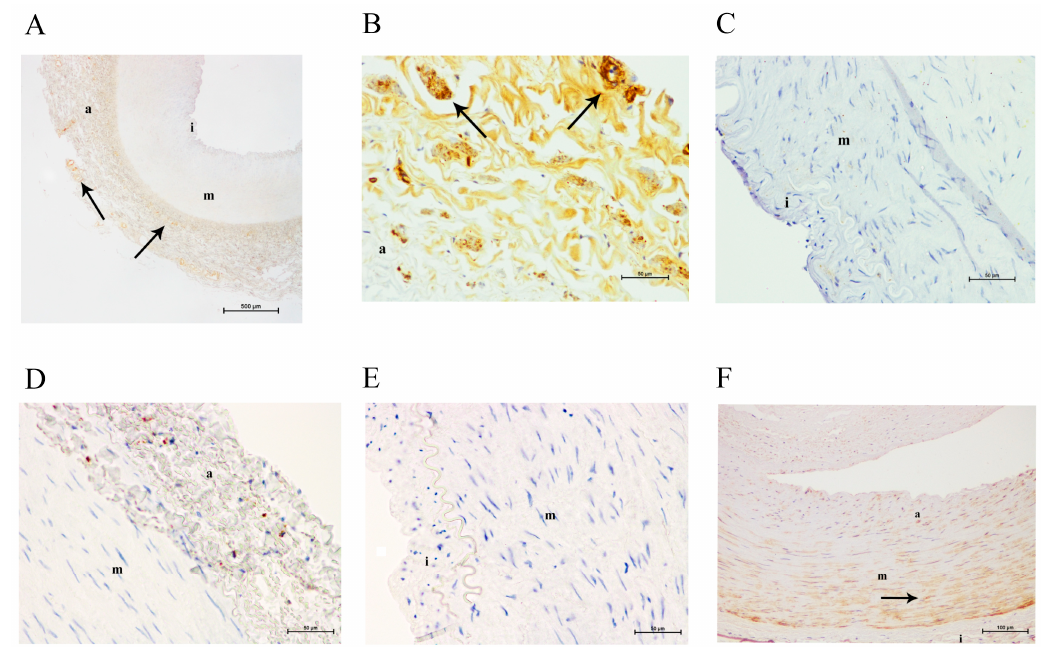
Figure 1. Immunohistochemical images of a normal femoral artery. ( A ) Galectin-3 staining in adventitia at a magnification of 40×; ( B ) galectin-3 staining in the adventitia at a magnification of 200×; ( C ) lack of galectin-3 staining in tunica media at a magnification of 200×; ( D ) faint CD68 staining in the adventitia at 200× magnification; ( E ) lack of CD68 staining in the media at 200× magnification; ( F ) α -actin staining in the media at 100× magnification. a , adventitia; m , media; i , intima. The arrows show positive immunostained areas.